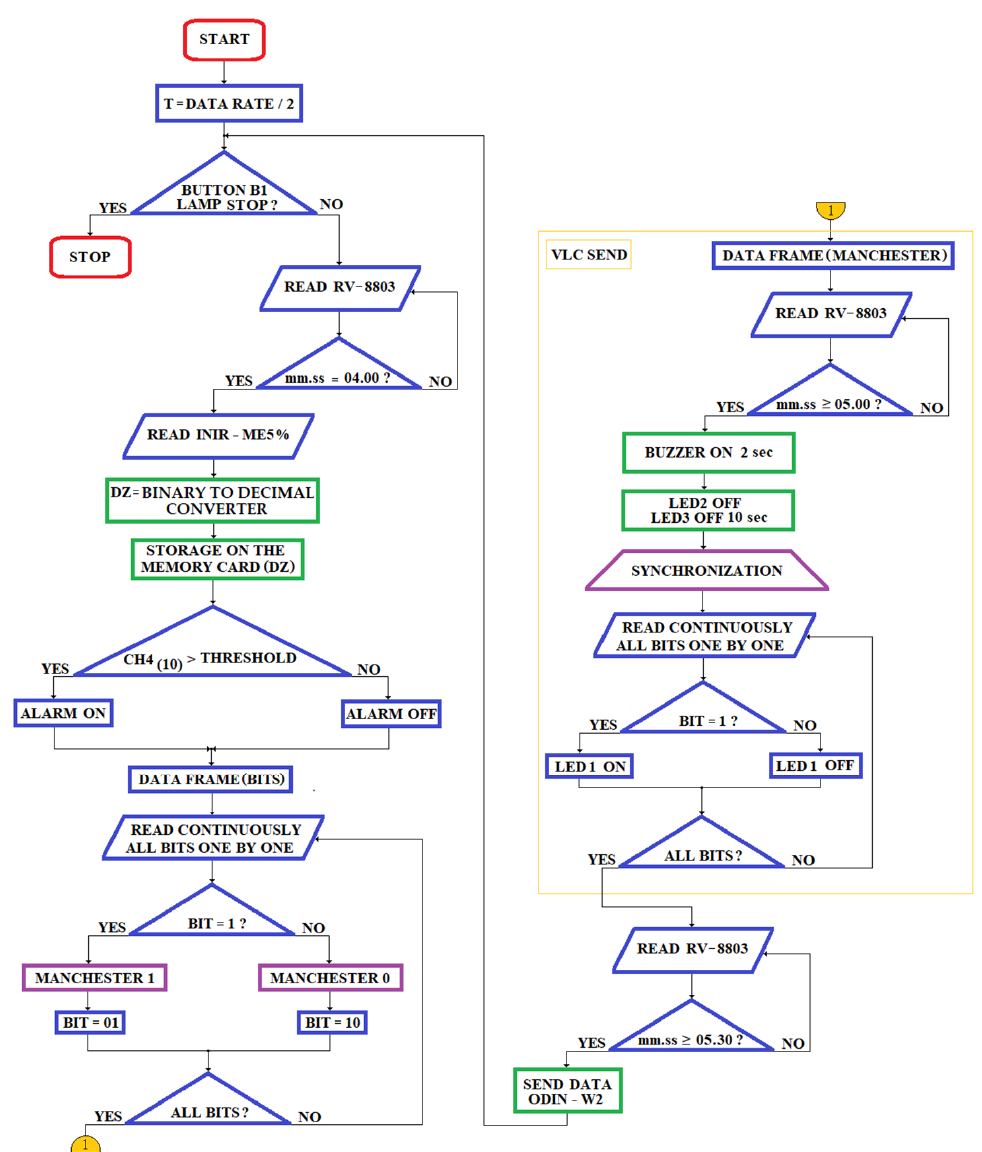
Figure 19. The data transmission algorithm within the mining lamps.